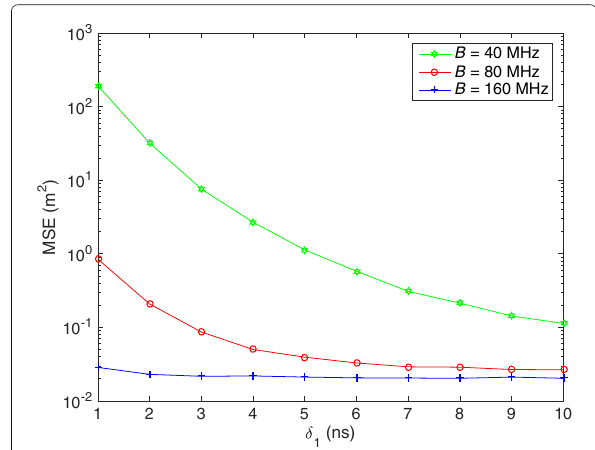
Fig. 10 Numerical result 8. MSE versus δ 1 with B as a parameter, for M = 4, ρ = 0 dB, N P = 10, and δ 0 = 10 ns